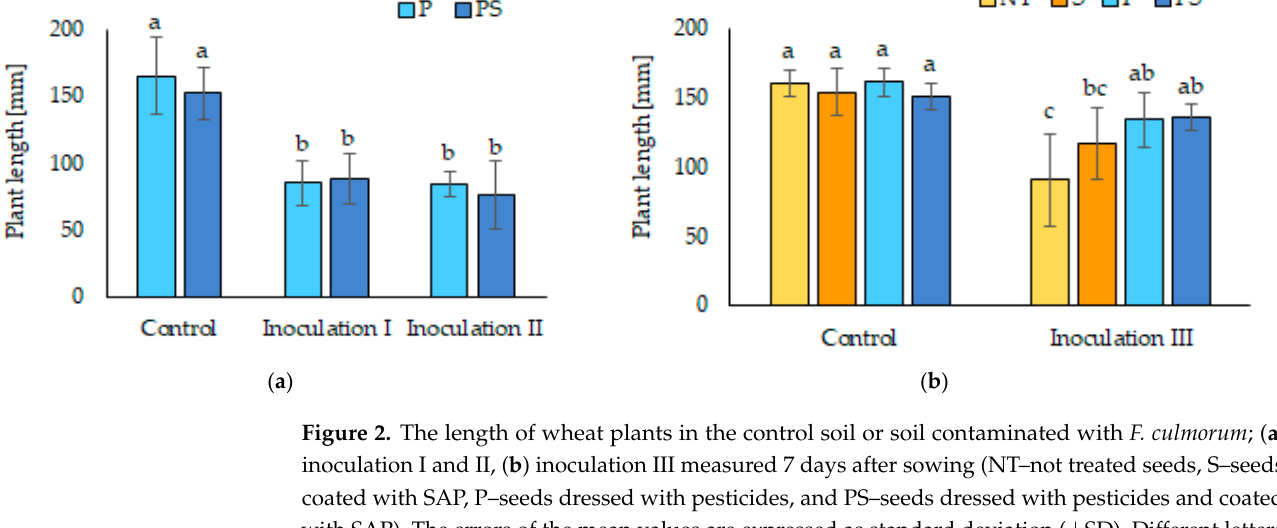
Figure 2. The length of wheat plants in the control soil or soil contaminated with F. culmorum ; ( a ) inoculation I and II, ( b ) inoculation III measured 7 days after sowing (NT–not treated seeds, S–seeds coated with SAP, P–seeds dressed with pesticides, and PS–seeds dressed with pesticides and coated with SAP). The errors of the mean values are expressed as standard deviation ( ± SD). Different letters indicate statistically significant differences by LSD test ( α = 0.05).